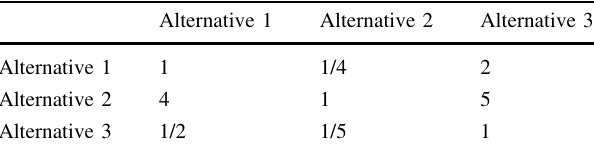
Table 2 Example of pairwise comparison matrix with respect to a criterion Alternative 1